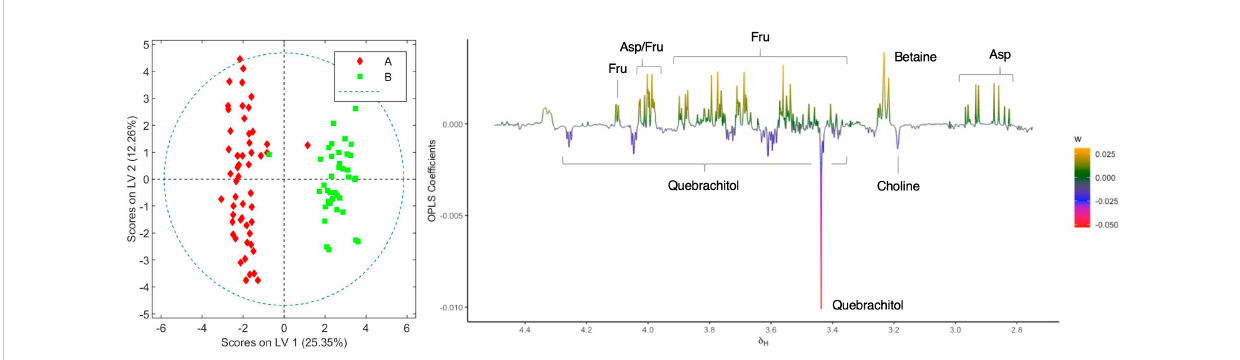
FIGURE 4 Score and loading factor plots obtained from the OPLS-DA between aqueous extracts of chemovars A and B. The metabolites that differentiate the two groups are annotated in the loading factor plots. The R 2 Y and Q 2 Y coef fi cients for the model were 0.91 and 0.83, respectively, and the ROC curve had an AUC value of 0.98 (see Figures S9,